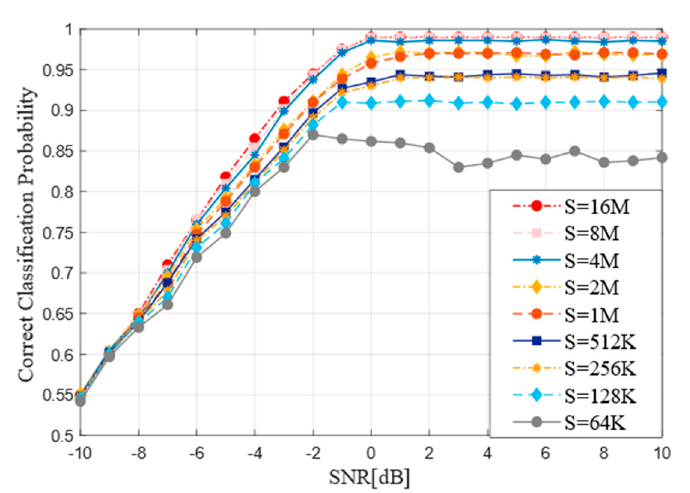
Figure 9. Recognition performance of the improved RNN in different sizes of training set (S).